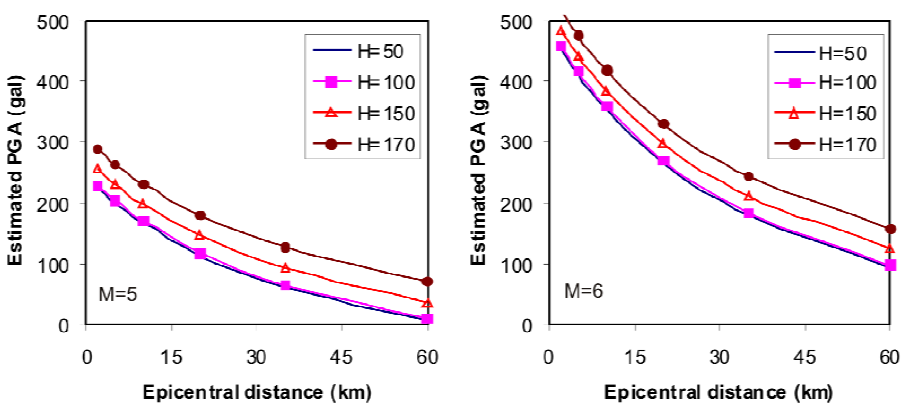
Fig. 9. Attenuation of the PGA with respect to slope height for M = 5 and M = 6 Figure 9. Attenuation of the PGA with respect to slope height for M=5 and M=6